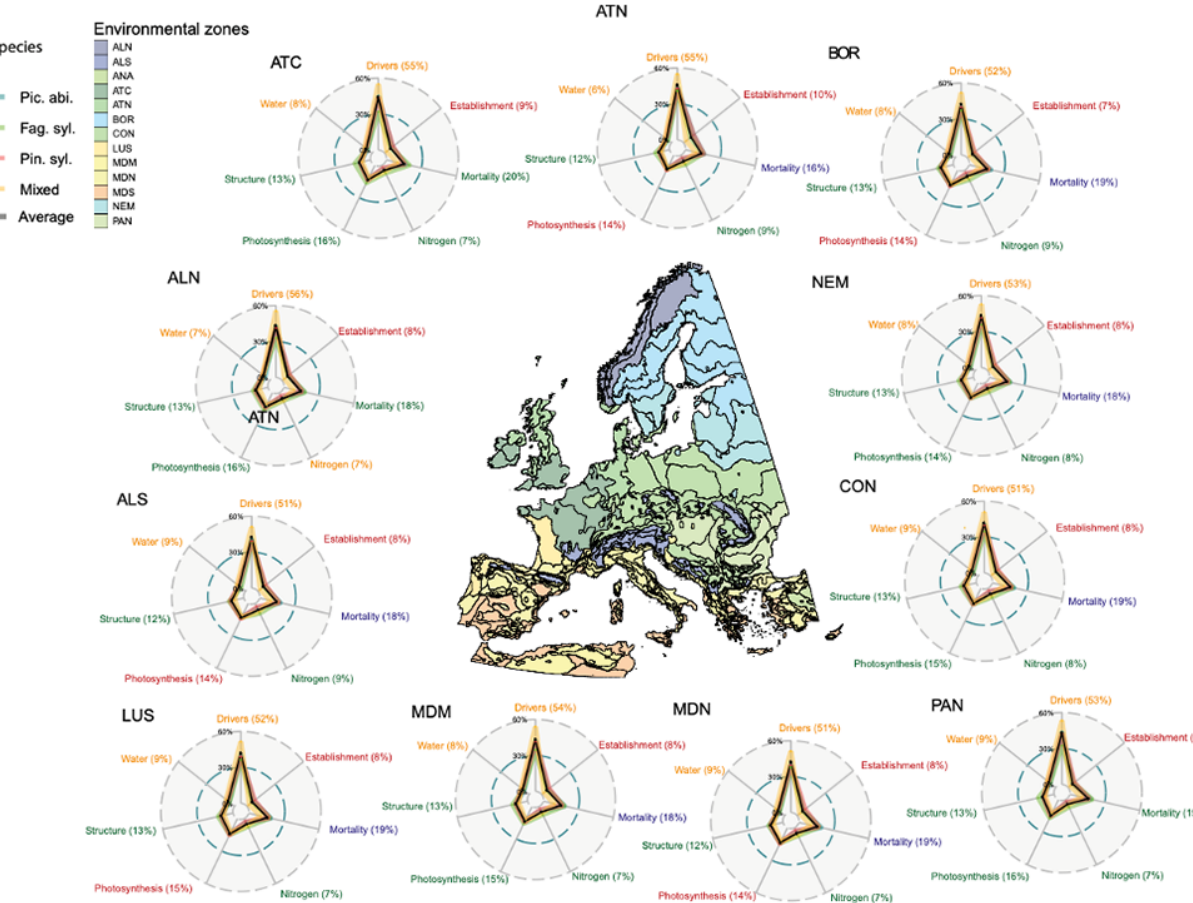
Figure 3. The aggregated relative uncertainties of total standing biomass per environmental zone (with more than five sites) show a higher importance of drivers in the south than in the north. The environmental zones are from Metzger et al. (2005) and are defined as follows: ALN, Alpine north; ALS, Alpine south; ANA, Anatolian; ATC, Atlantic central; ATN, Atlantic north; BOR, Boreal; CON, Continental; LUS, Lusitanian; MDM, Mediterranean mountains; MDN, Mediterranean north; MDS, Mediterranean south; NEM, Nemoral; and PAN, Pannonian. In the radar plots of each environmental zone, the color and percentage value of the process label indicates which simulation setup (monospecific with corresponding species or mixed stands) has contributed most uncertainty and how